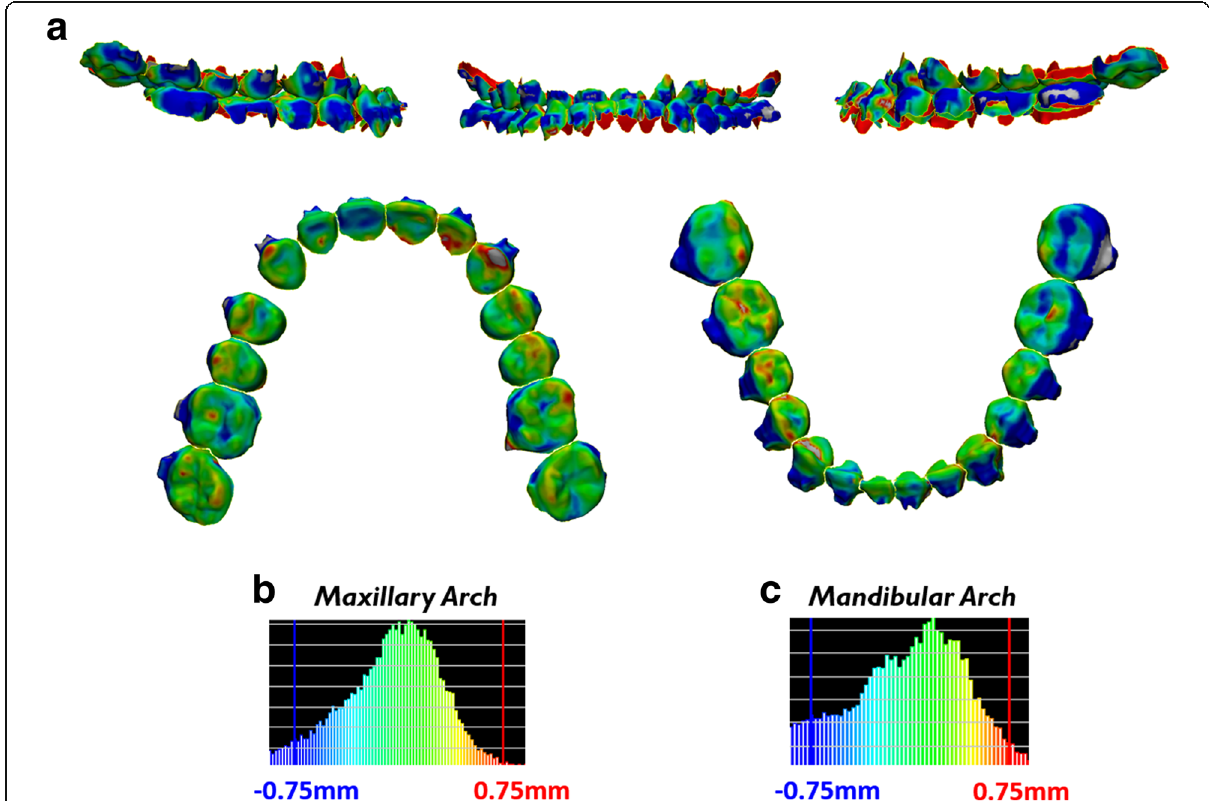
Fig. 5 Verification of accurate crown superimposition after direct superimposition between the crowns of the reset appointment CBCT teeth and the reset appointment laser scan. a Color displacement maps comparing the crown positions of the reset appointment CBCT crowns and reset appointment laser scan crowns. Green areas indicate 0.0 mm displacement; blue and red areas indicate equal to or greater than 0.75 mm. b , c Histograms showing the distribution of displacements between crowns of the reset appointment CBCT scan and reset appointment laser scan in the maxillary arch and mandibular